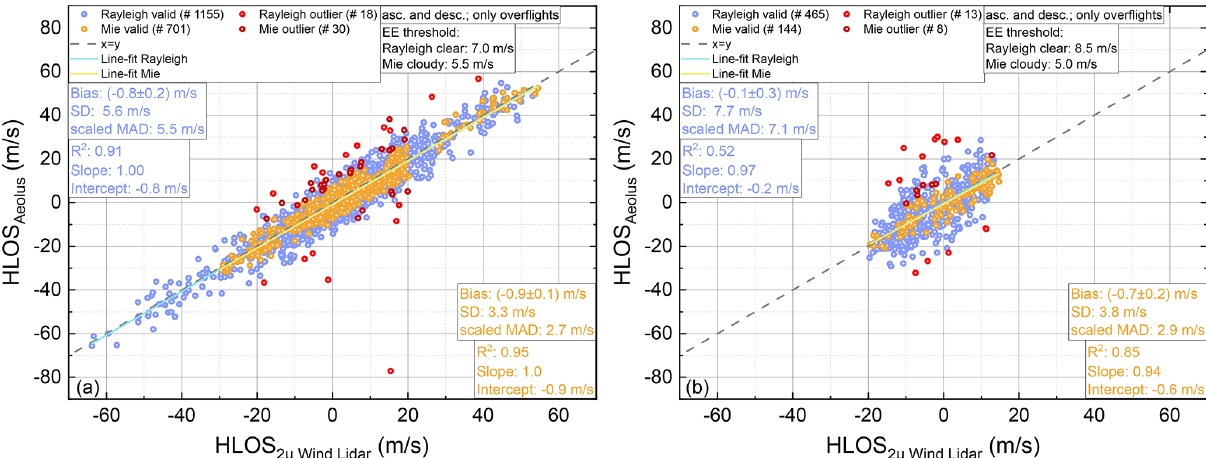
Figure 5. Aeolus HLOS wind speed plotted against the 2µmDWL wind speed, projected onto the horizontal viewing direction of Aeolus for the 10 underflights performed during the AVATAR-I campaign (left) and for the 11 underflights performed during the AVATAR-T cam- paign (right). The wind measurements are separated into Rayleigh-clear winds (blue) and Mie-cloudy winds (orange). Outliers that exceeded a modified Z -score threshold of 3 are indicated by light red and dark red points, respectively. Corresponding least-square line fits are indi- cated by the light-blue and yellow line, respectively. The fit results are shown in the insets. The x = y -line is represented by the gray dashed